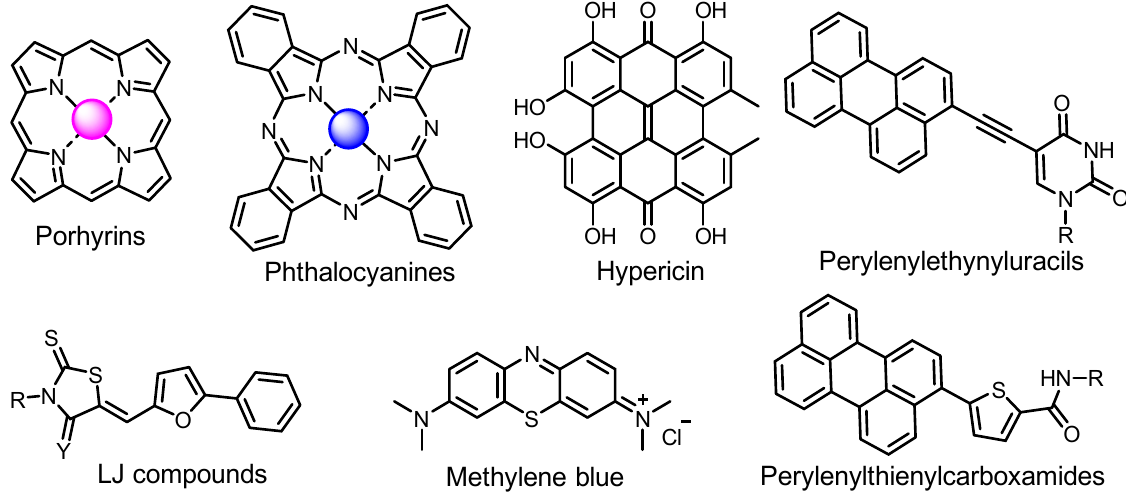
Figure 2. Main scaffolds of antiviral photosensitizers. To solve this problem, several options were proposed, ranging from placing a light source inside the body using various medical devices to introducing, together with a photosensitizer, an auxiliary molecule that emits electromagnetic radiation of the desired wavelength through various chemiluminescent processes. Moreover, the damaging